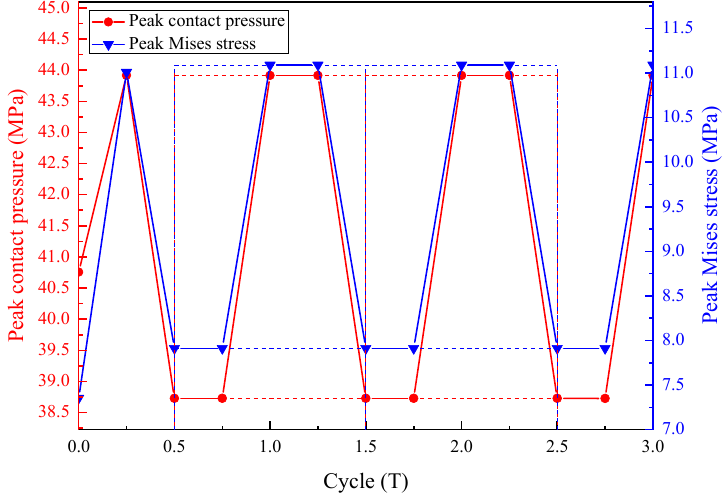
Figure 8. The peak contact pressure and peak Mises stress changes during 0–3 T ( A f = 1.2 mm). In conclusion, when the A f increases from 0 mm to 2 mm, the fretting of the X-ring runs in the sticking region, the mixed slip region, and the gross slip region successively.